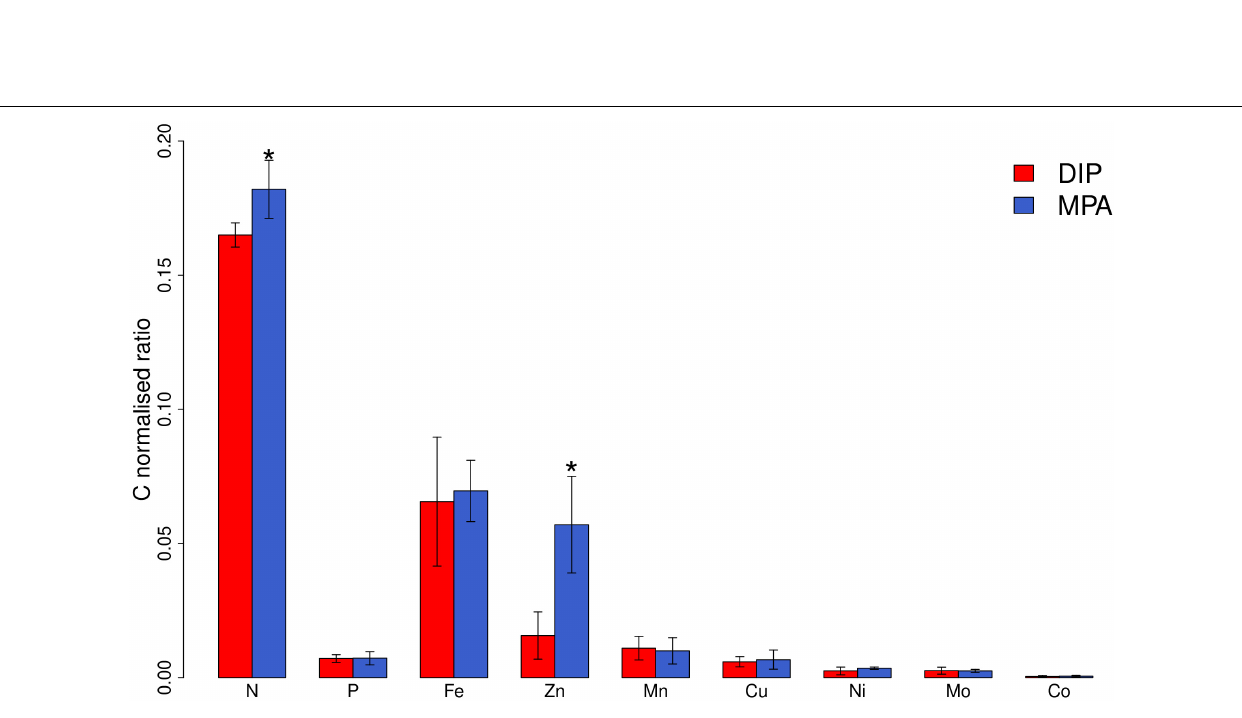
Frontiers in Microbiology |